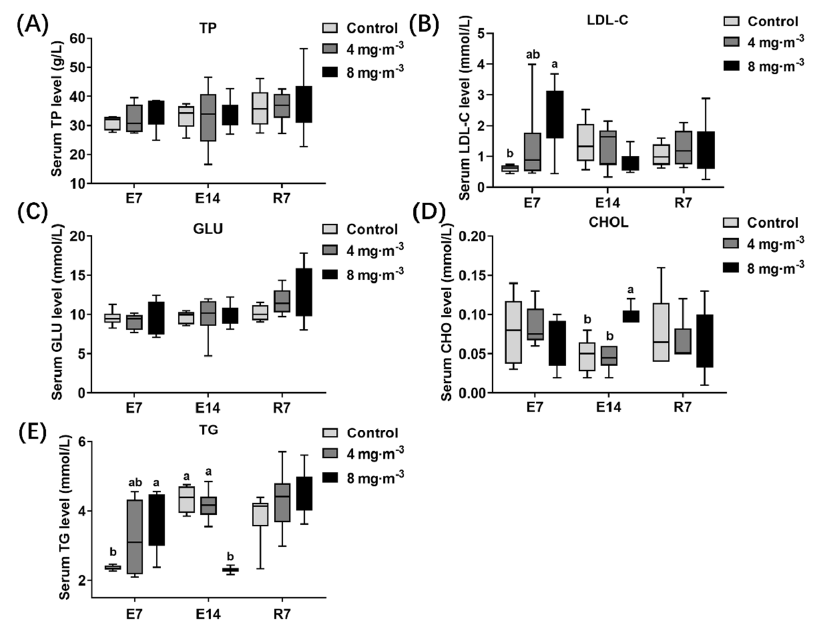
Figure 7. Effects of particulate matter exposure on lipid concentration in serum of broilers. ( A – E ) represent the TP, LDL-C, GLU, CHOL, and TG levels in serum of broilers after E7, E14, and R7, respectively. Data are presented as mean ± SEM of groups (n = 8). Different letters indicate statisti- cally significant differences between groups ( p < 0.05). E7, exposure for 7 days; E14, exposure for 14 days; R7, recovery for 7 days.